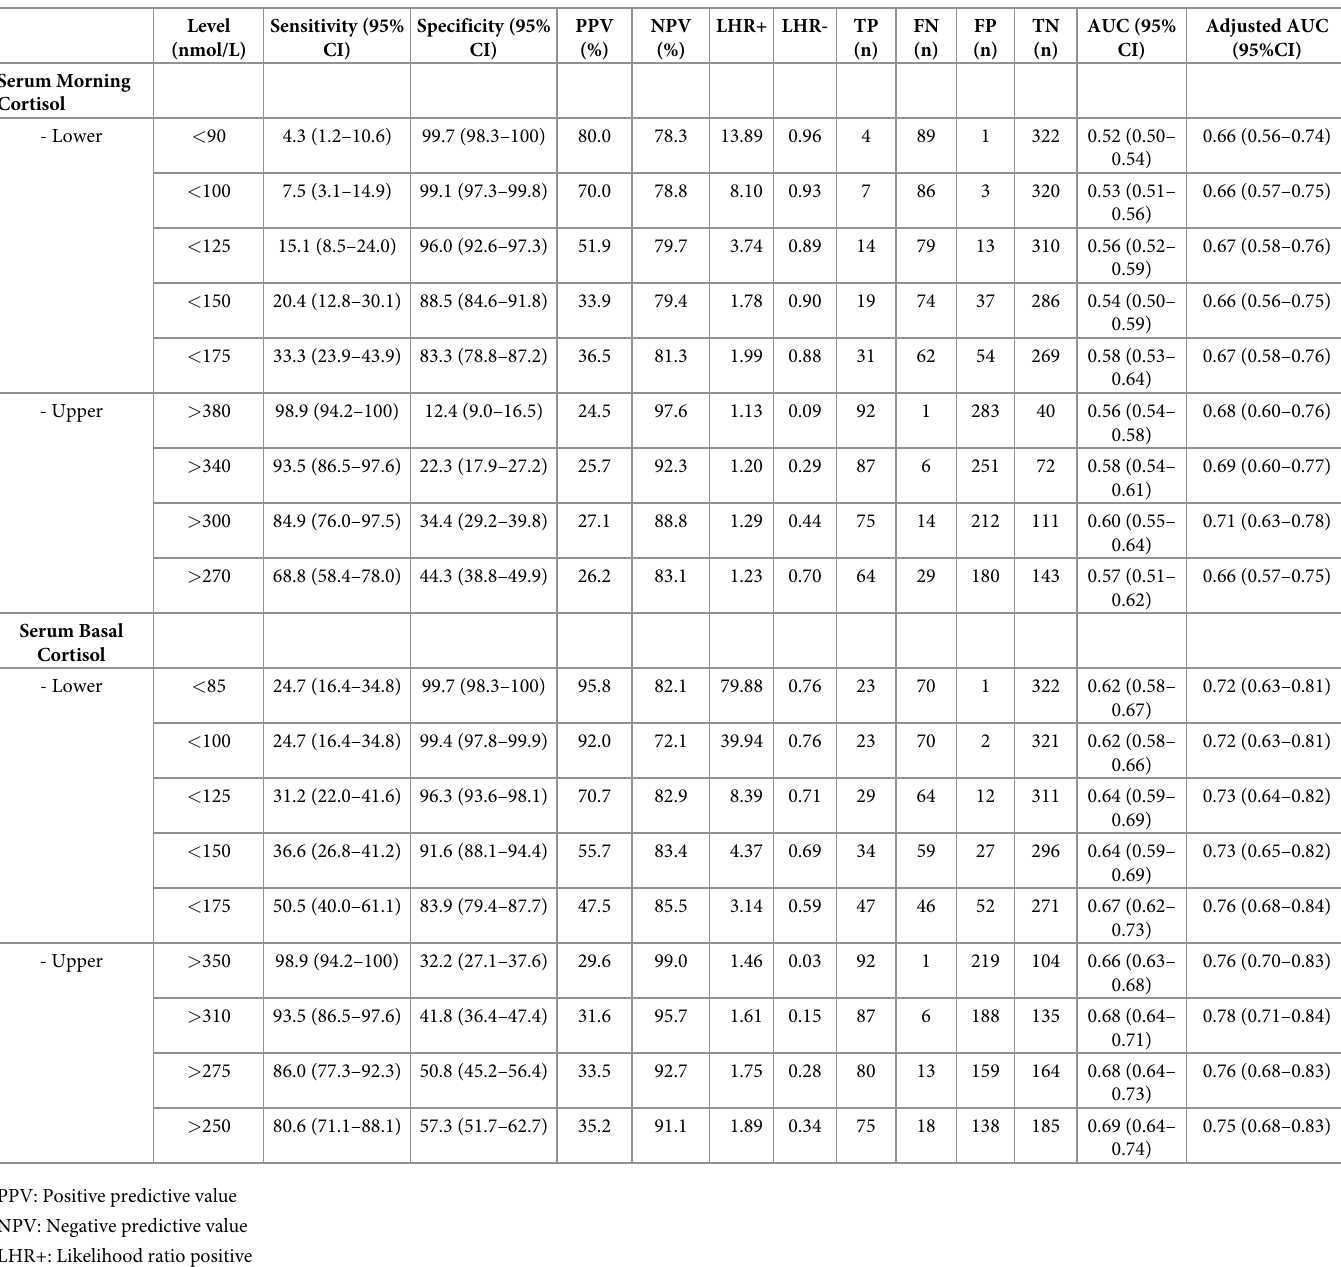
Table 3. Accuracy of the cut-off level for 0800 h serum morning and basal cortisol